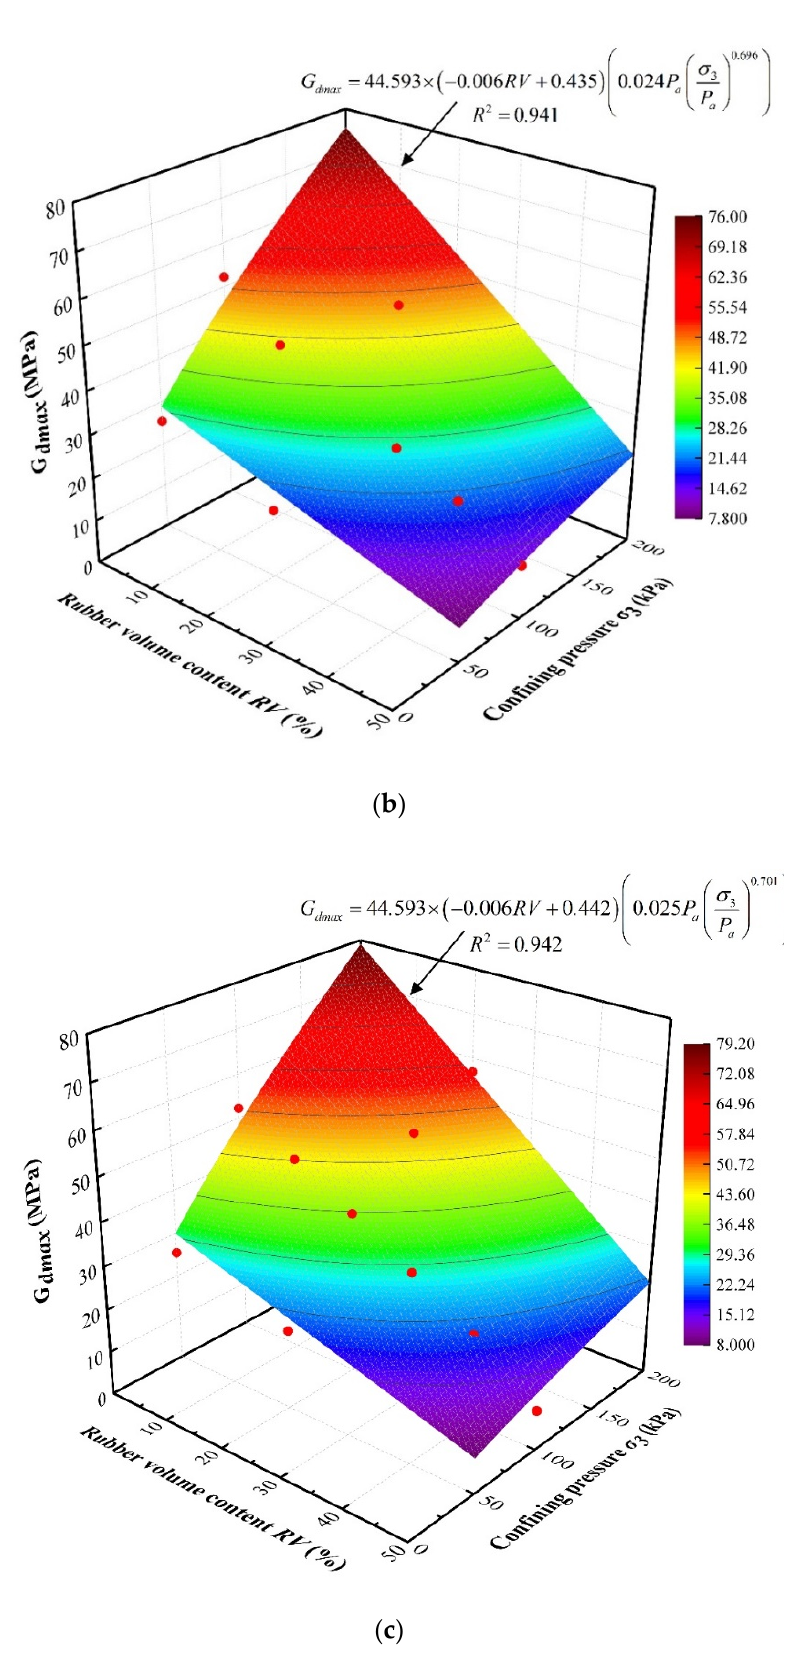
Figure 18. Empirical model of maximum dynamic shear modulus ( G dmax ) according to rubber content and confining pressure for different rubber particle sizes: ( a ) SRP1; ( b ) SRP2; ( c ) SRP3.